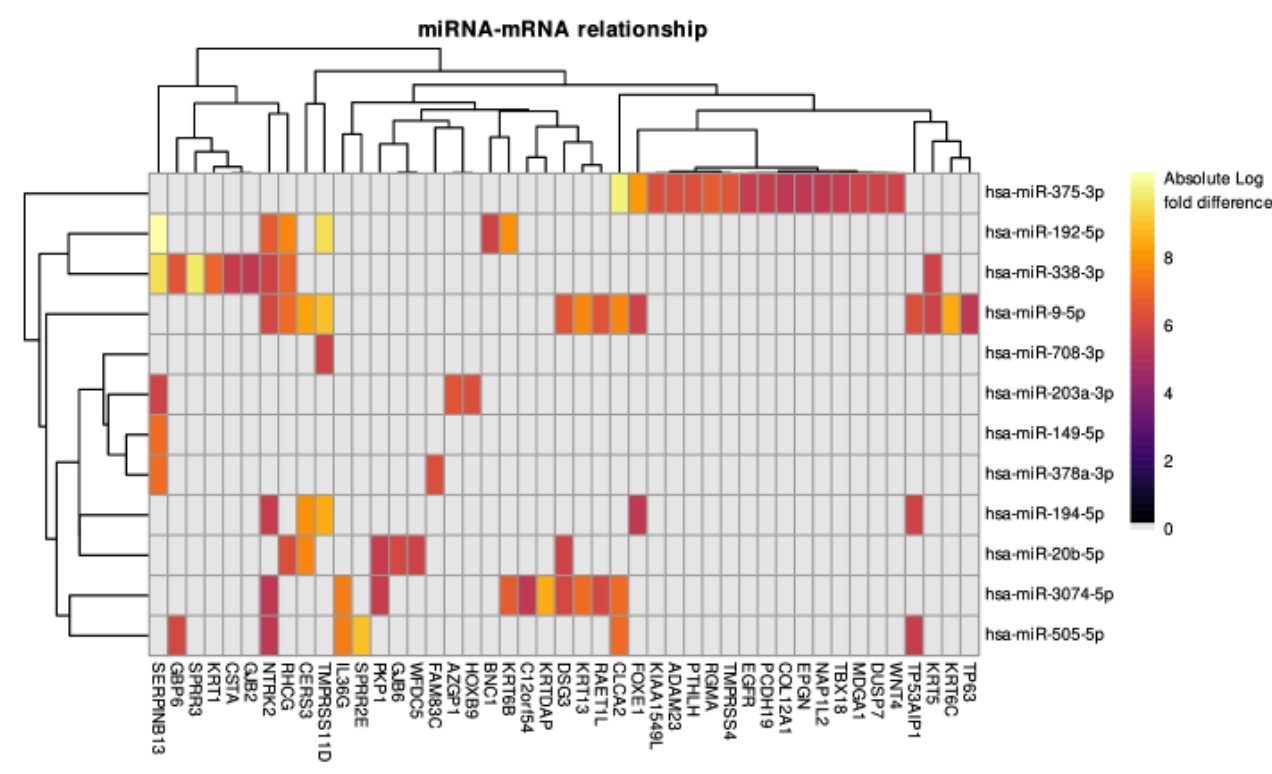
Figure 5. High keratinization vs. low keratinization groups heatmap of all significant miRNA–mRNA interrelations predicted by both mirTarRnaSeq and miRanda. Gray color represents no significant interrelation identified by mirTarRnaSeq. The heatmap units are the absolute difference between miRNA and mRNA fold changes.